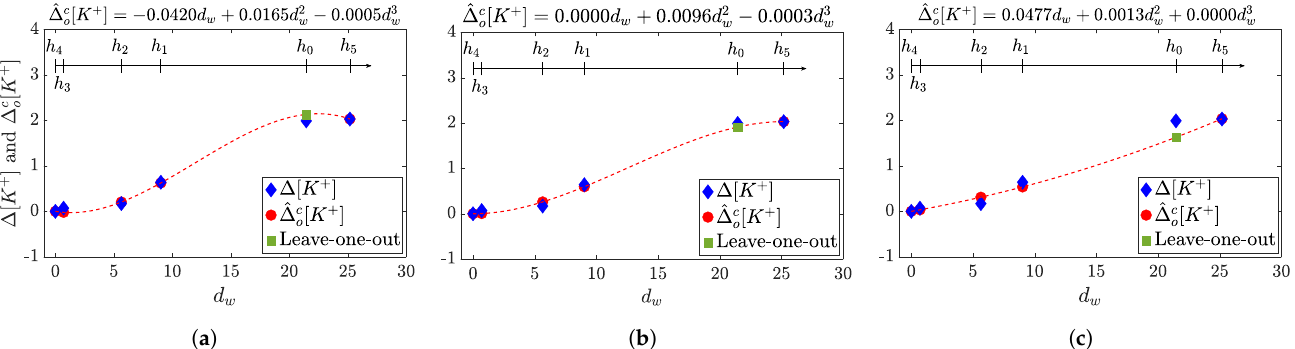
( p , h ) ) distributions across patients for each hour h Figure 4. Estimation error ( e f i i and when pooling all samples together d , m (ALL). Panels ( a , d ) show results for linear models f = l ; panels ( b , e ) show the quadratic and panels f = q ; and ( c , f ) show the cubic model f = c . Yellow dots represent individual error values when m = a , while light-blue ones denote those obtained when m = o . Corresponding boxplots are depicted on top of each distribution: The black ones represent the errors in m = a while the red ones represents error in case of m = o . “+” denotes outliers.